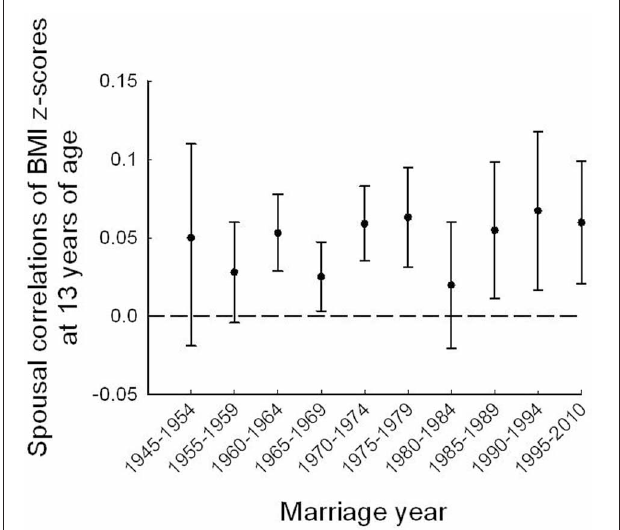
FIGURE 2 | Spousal correlations for standardized BMI z -scores from age 13 years with 95% CI estimates, by 5-year intervals of marriage cohort.